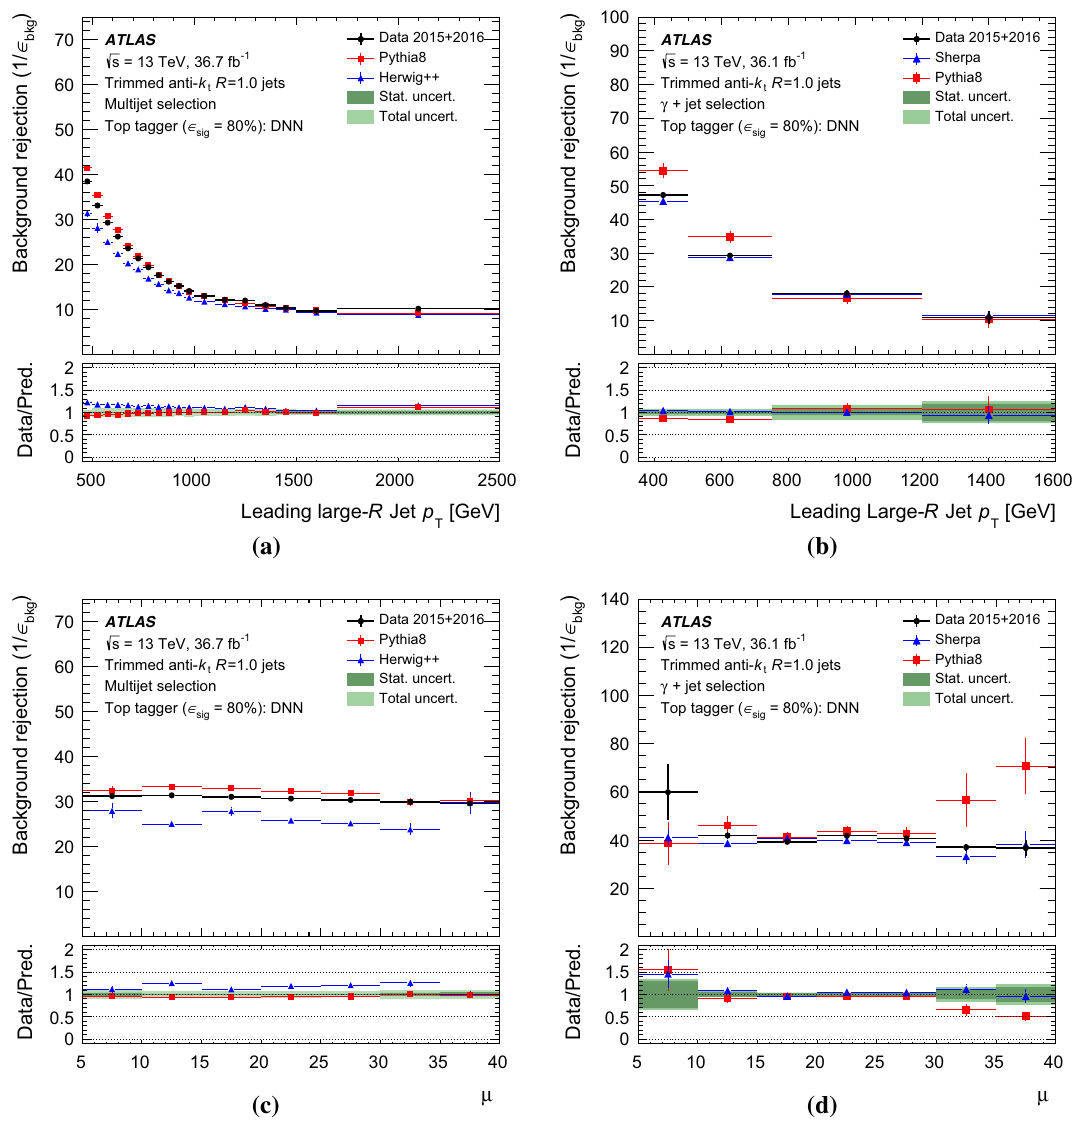
Fig. 36 The estimated light-jet rejection 1 /(cid:12) bkg as a function of the leading jet p T and the average number of interactions per bunch crossing μ for the DNN top-quark tagger in the multijet ( a , c ) and γ + jet ( b , d ) selection